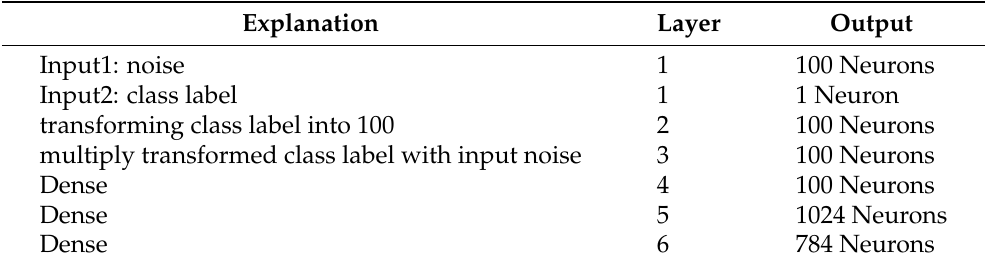
Table A1. The architecture of the generator used for the fmnist-based datasets.